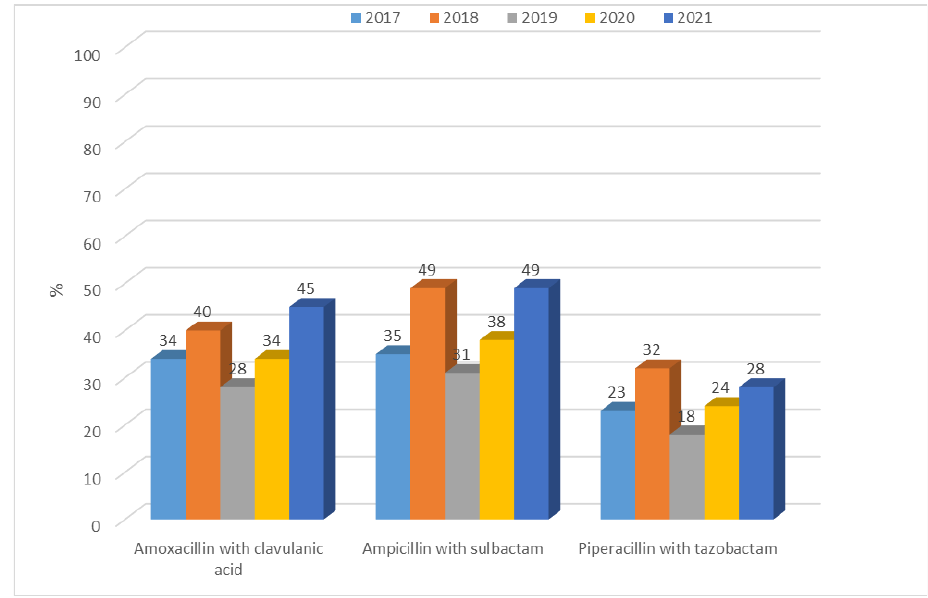
Figure 13. Percentage of K. pneumoniae ESBL(−) resistant strains with inhibitor penicillins.